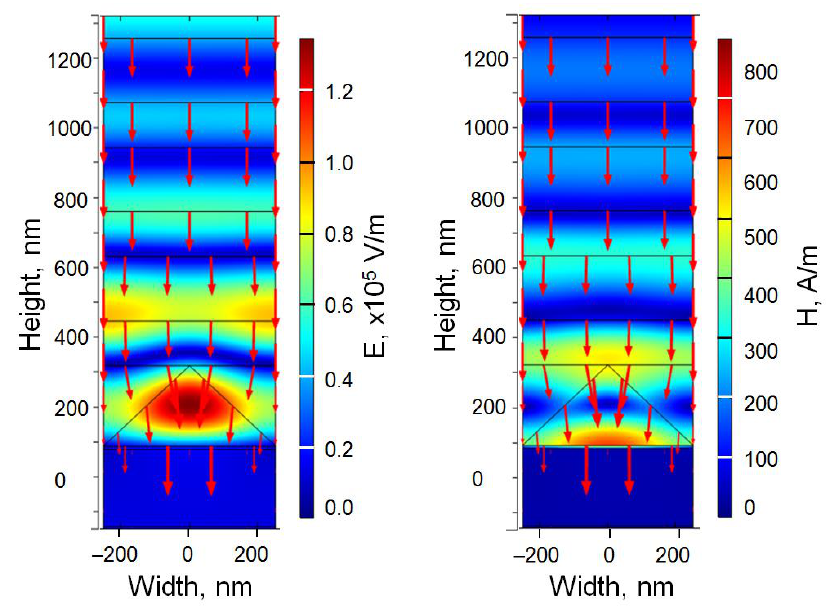
Figure 6. Spatial distribution of the electric ( left image ) and magnetic ( right image ) fields for TM polarization at 1060 nm at the cross-section of the structure with embedded blazed diffraction grating (as shown in Figure 1b). Red arrows represent the power flow.